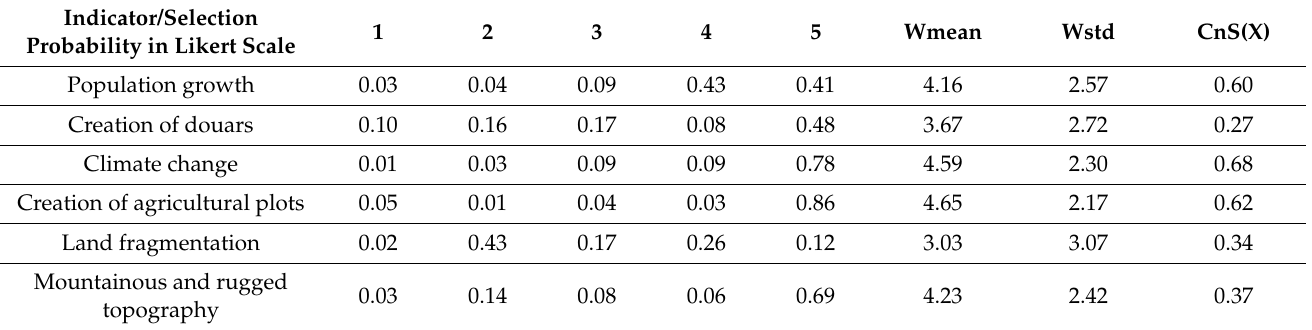
Table 6. Driving forces of land use/land cover changes as perceived by